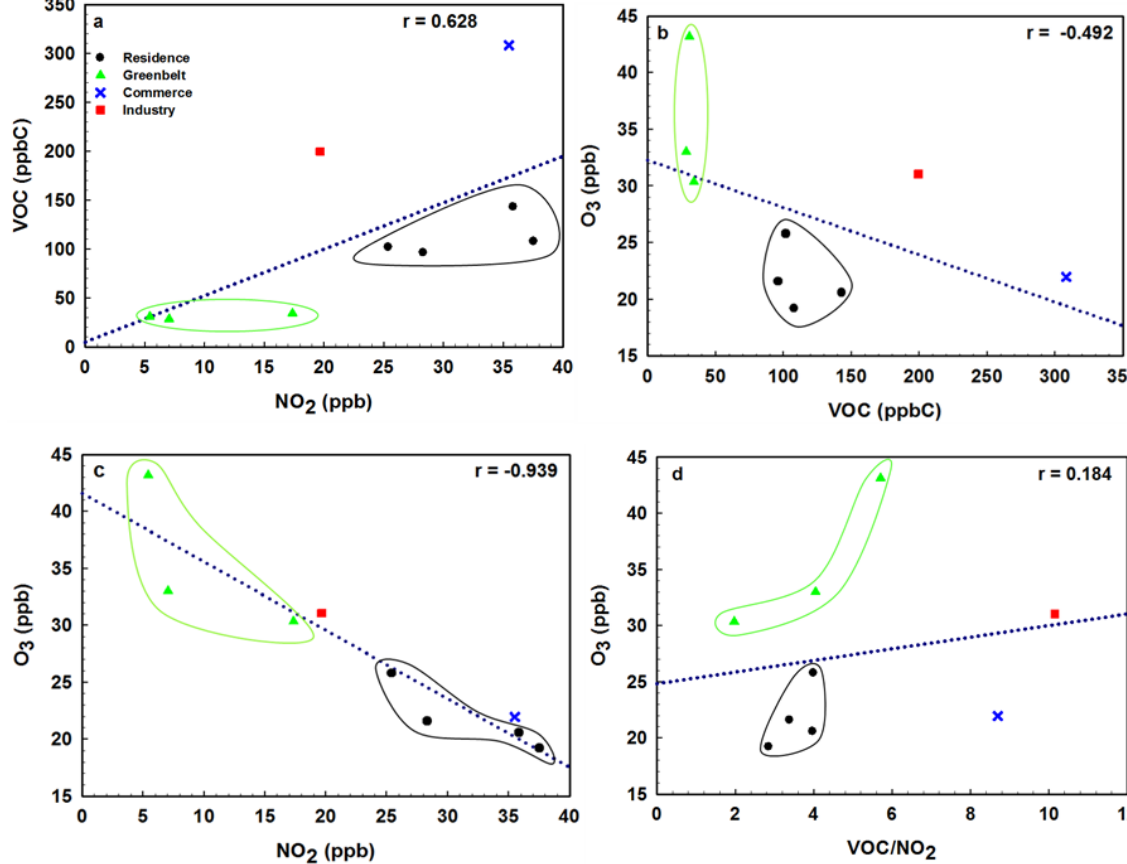
Figure 11. Scatter diagrams of the long-term averages of (a) VOCs versus NO 2 , (b) O 3 versus VOCs, (c) O 3 versus NO 2 , and (d) O 3 versus the ratio of VOCs / NO 2 at nine of the photochemical air pollution monitoring stations over South Korea since 2007 under the following four land-use types: residence (black circle), commerce (blue cross), industry (red square), and greenbelt (green triangle). The correlation coefficient ( r ) and the regression dotted line were also